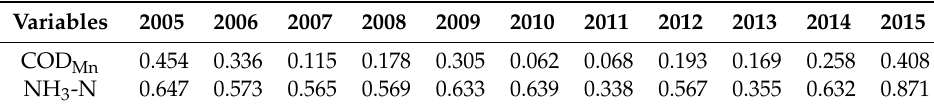
Table 3. Moran’s I values for COD Mn and NH 3 -N between 2005 and